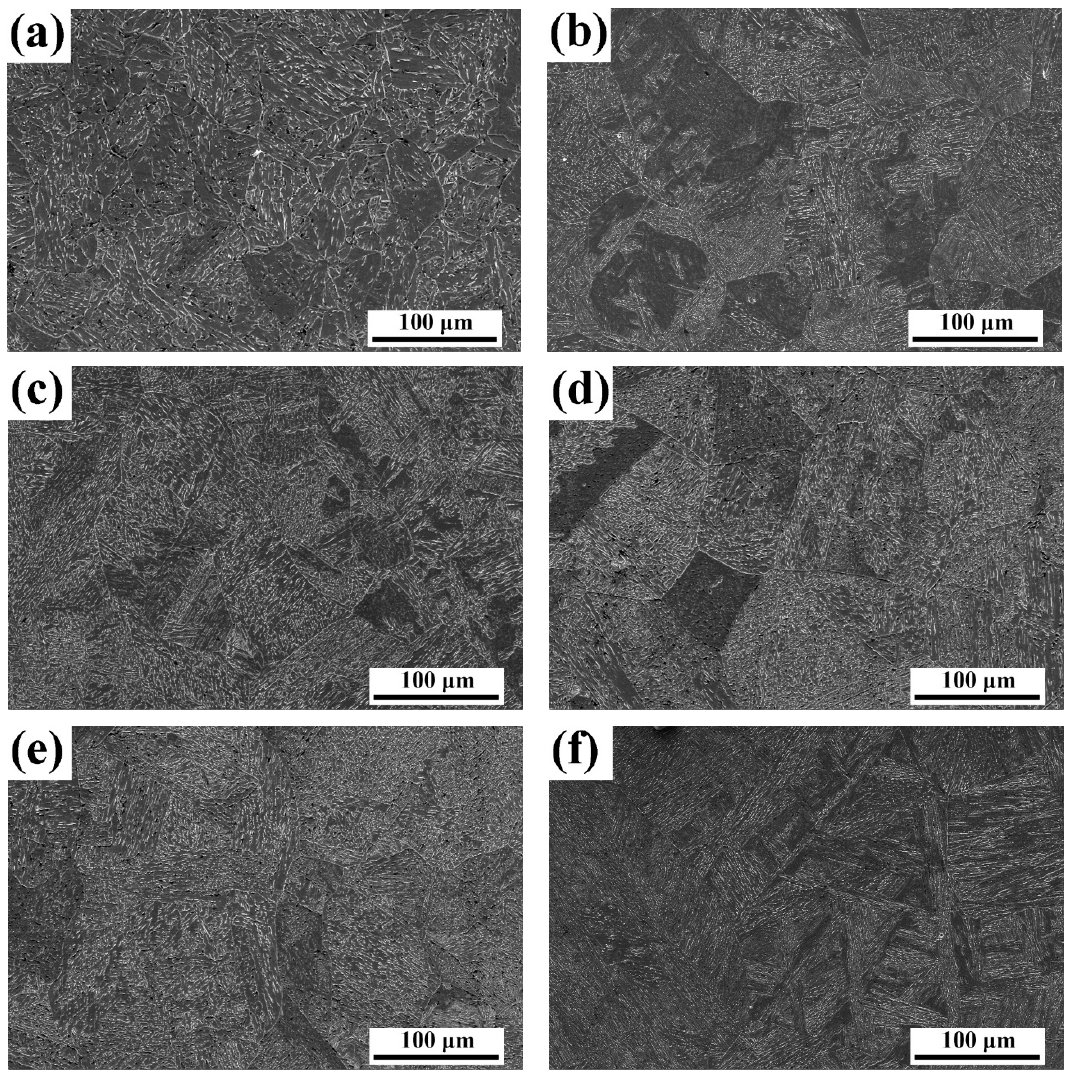
Figure 3. SEM morphologies of the samples heated to 1150 °C for different holding times: ( a ) 1 s, ( b ) 10 s, ( c ) 20 s, ( d ) 40 s, ( e ) 100 s, and ( f ) 500 s.